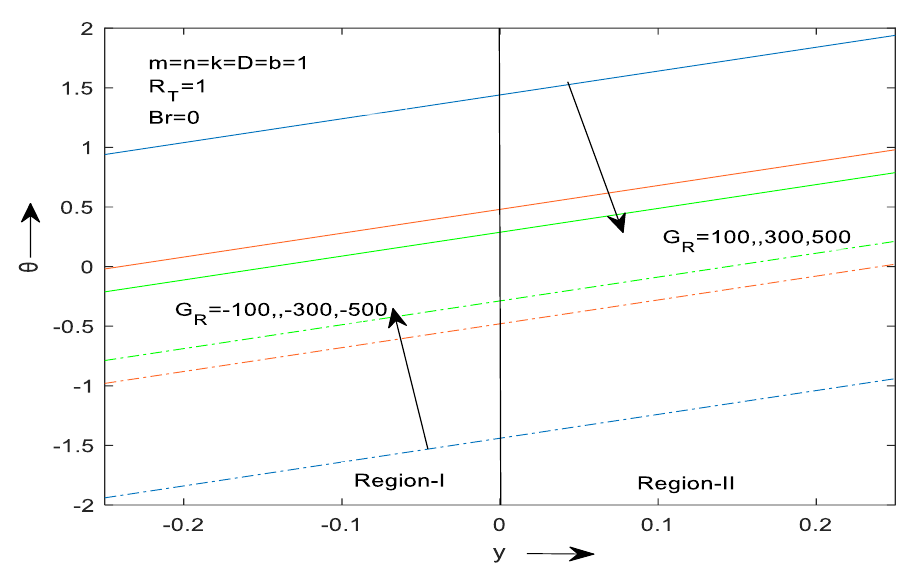
Fig. 2b. Temperature profiles for different values of G